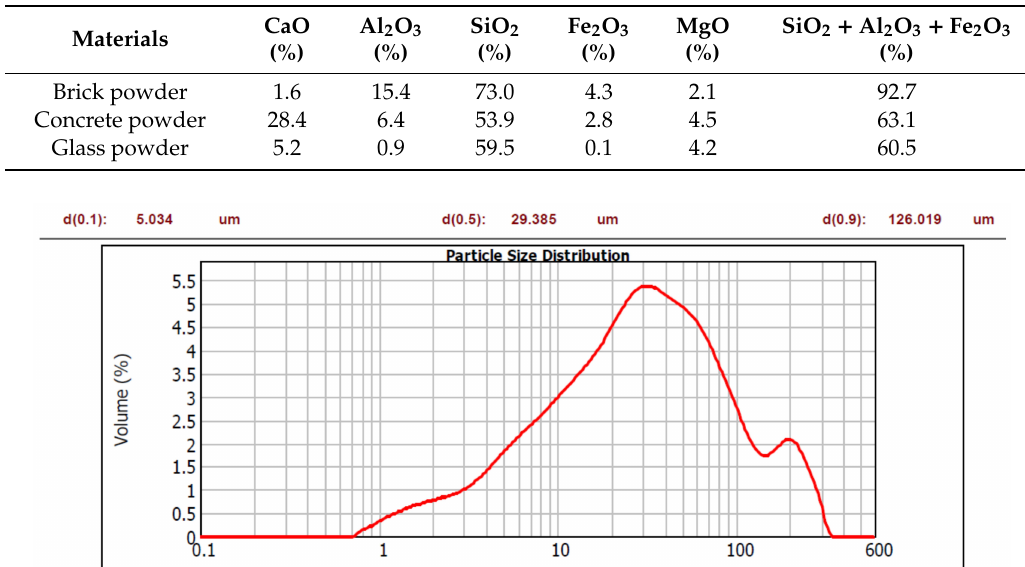
Table 1. Chemical composition of tested powders.